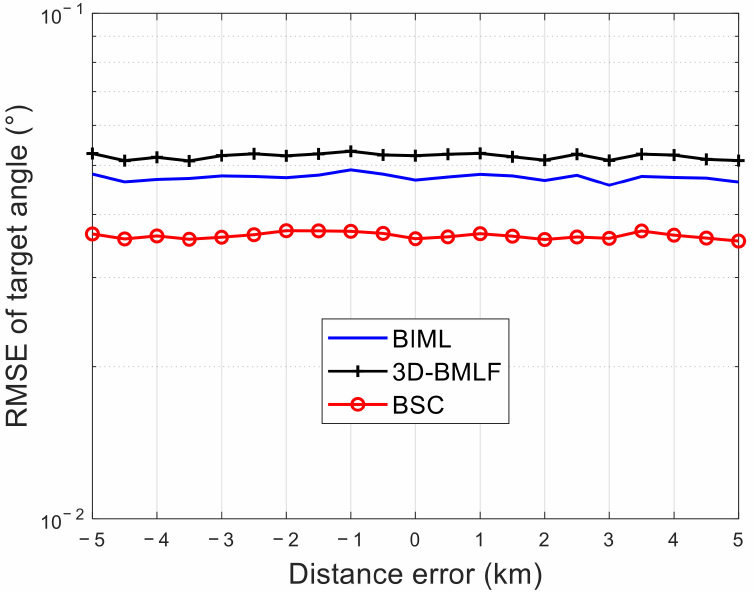
Figure 8. The RMSEs of the target angle for the three algorithms against the target distance error.